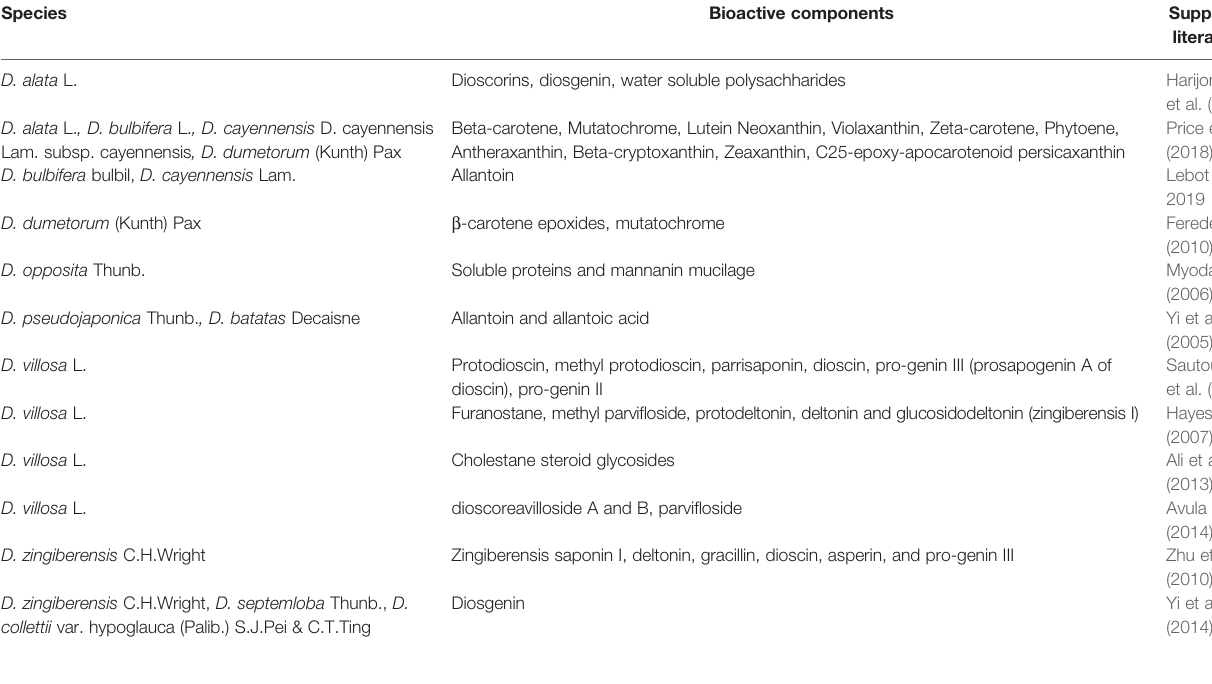
TABLE 3 | Different bioactive compounds present in Dioscorea species.